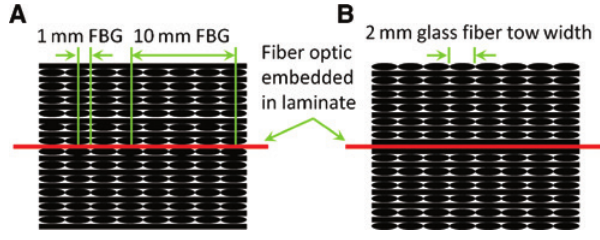
Figure 9: Schematics of an embedded FBG. (A) [0/90] with fiber optic in 0 ° direction. (B) [90/0] 6S optic in 0 °